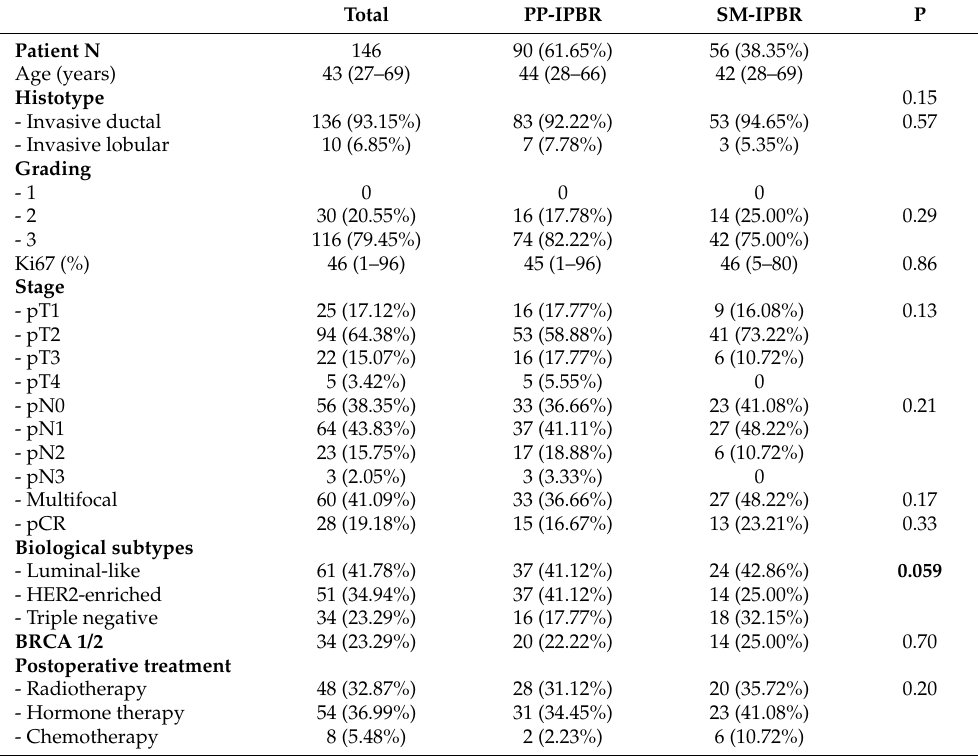
Table 1. Patient characteristics and clinicopathological